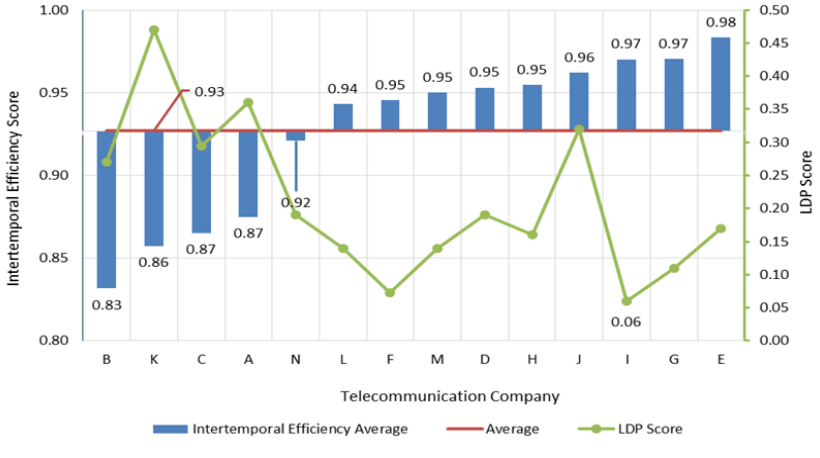
Figure 1: Intertemporal Efficiency Score of Telecommunications Industry in ASEAN-5 Source: Data